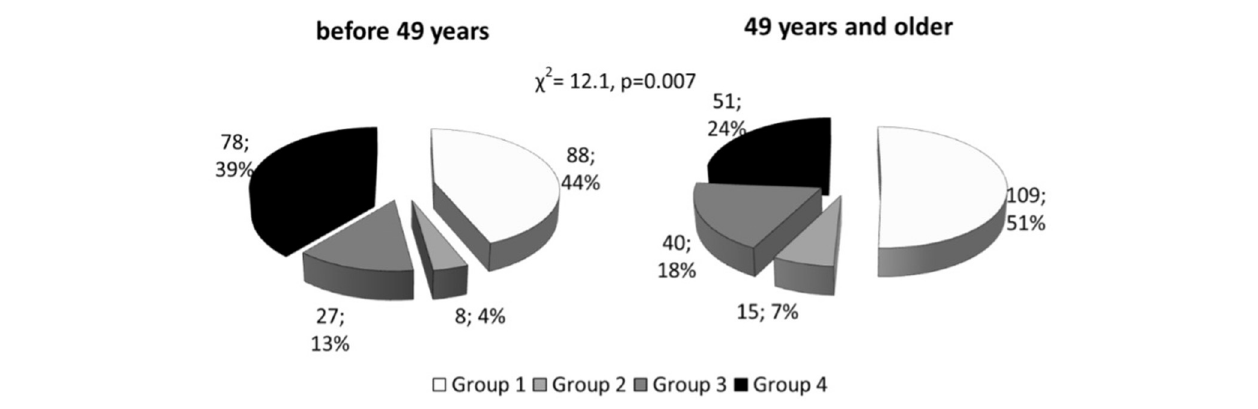
FIGURE 1 | Distribution of patients with coronary heart disease onset before and after median age, stratified according to Lp(a) level and apo(a) phenotype. Lp(a), lipoprotein(a); Group1, HMW apo(a) and Lp(a) < 50 mg/dL; Group 2, HMW apo(a) and Lp(a) ≥ 50 mg/dL; Group 3, LMW apo(a) and Lp(a) < 50 mg/dL; Group 4, LMW apo(a) and Lp(a) ≥ 50 mg/dL; LMW apo(a), low-molecular weight apo(a) phenotype; HMW, high-molecular weight apo(a) phenotype.